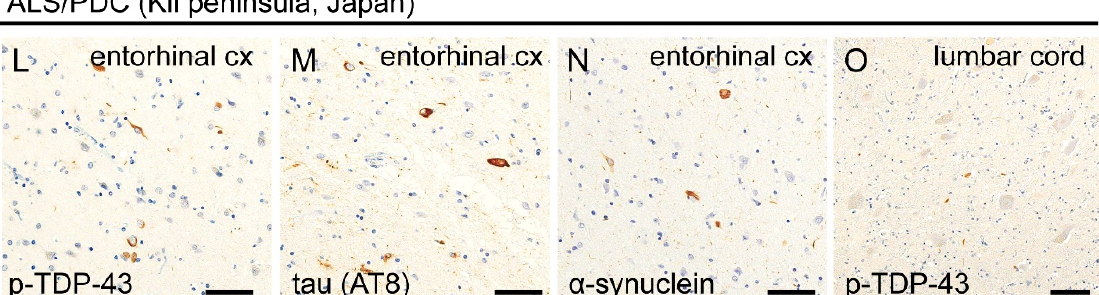
Figure 2. Histopathological findings of transactivation response DNA binding protein 43kDa (TDP-43)-related ALS (ALS-TDP) and FTLD (FTLD-TDP). Panels A–D were taken from an ALS-TDP patient. Anti-TDP-43 immunohistochemistry revealed that TDP-43 was mislocalized from the nucleus to the cytoplasm and forms dot-like ( A , arrow) or skein-like inclusions ( B , arrow) in the spinal motor neuron. Unaffected neurons showed nuclear localization of TDP-43 ( A and B , arrowheads). Anti-phosphorylated TDP-43 (p-TDP-43) immunohistochemistry revealed pathologic inclusions ( C , arrow) but not the normal nuclear expression of TDP-43. TDP-43 inclusions were immunopositive for ubiquitin ( D , arrow). Bunina bodies are also observed in the motor neurons of ALS-TDP patients ( E ) and immunolabeled with cystation-C ( F ). Panels G – K were taken from FTLD-TDP patients. Sporadic FTLD-TDP is classified into types A, B, and C; type A is characterized by short dystrophic neurites and round- or crescent-shaped neuronal inclusions in the superficial layers of the cerebral cortex; type B is characterized by ring-shaped neuronal inclusions across all cortical layers; and type C is characterized by long and thick immunopositivity of neurites in the superficial cortical layers ( G – I ). Hippocampal granule cells ( J ) and neostriatum ( K ) are also preferentially involved. Panels ( L – O ) were taken from an ALS/ parkinsonism-dementia complex (PDC) (Kii peninsula) patient. The entorhinal cortex ( L – N ) showed multiple proteinopathies, including p-TDP-43 ( L ), hyperphosphorylated tau ( M ), and α-synuclein ( O ). Relatively mild aggregation of p-TDP-43 was observed in the spinal cord, compared with classical ALS. Scale bars: ( A , B ) 20 μm, ( C – F ) 10 μm, and ( G – O ) 50 μm.